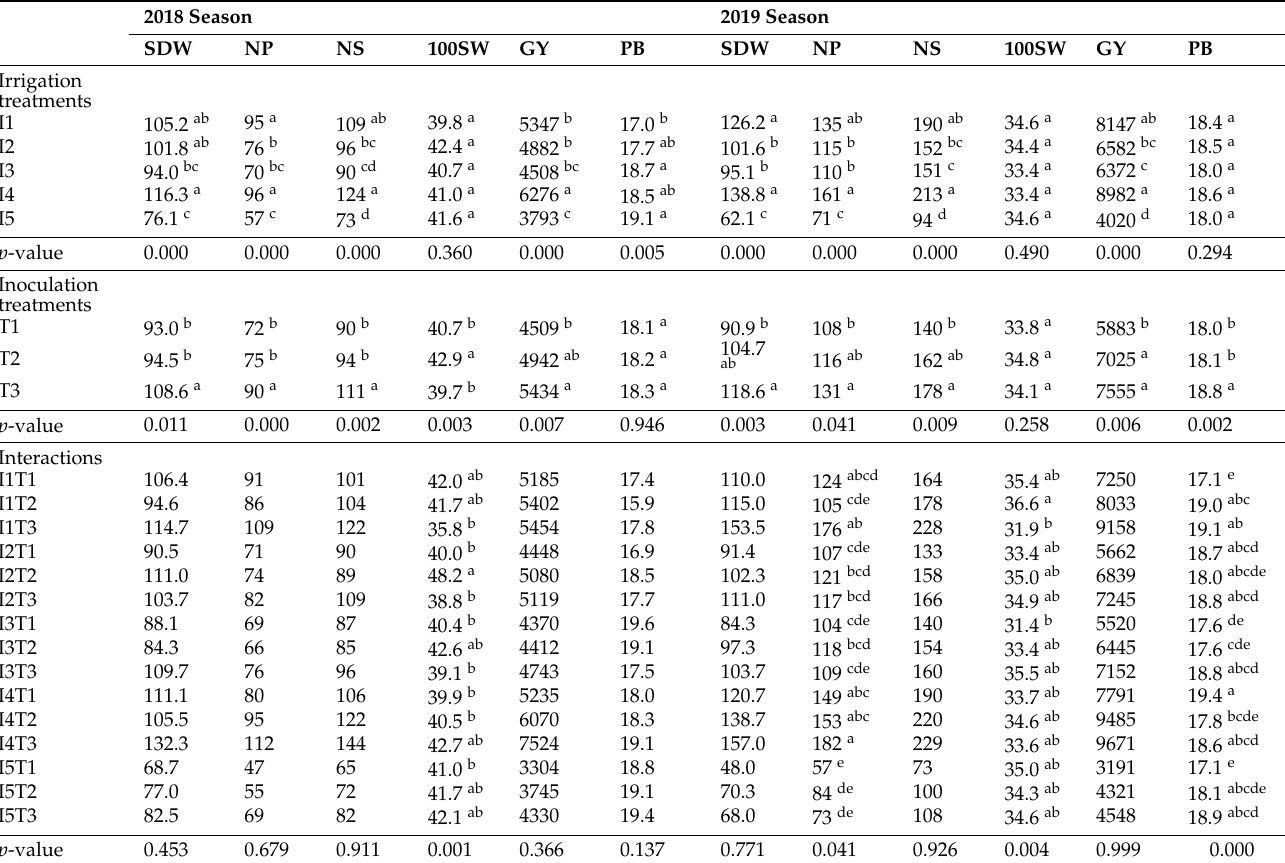
Table 3. Effect of different irrigation regimes and inoculation treatments and their interaction on shoot dry weight (g plant − 1 ), number of pods per plant, number of seeds per plant, 100-seed weight (g), grain yield (kg ha − 1 ) and crude protein content (%) of chickpea during 2018 and 2019 growing